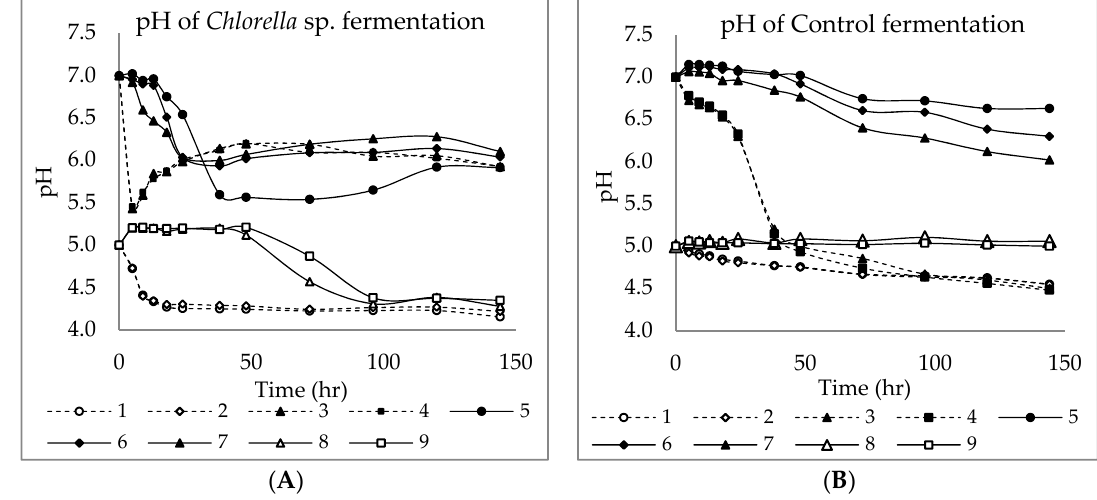
Figure 4. pH during fermentation in different batches: (A) Chlorella sp.; and (B) control.